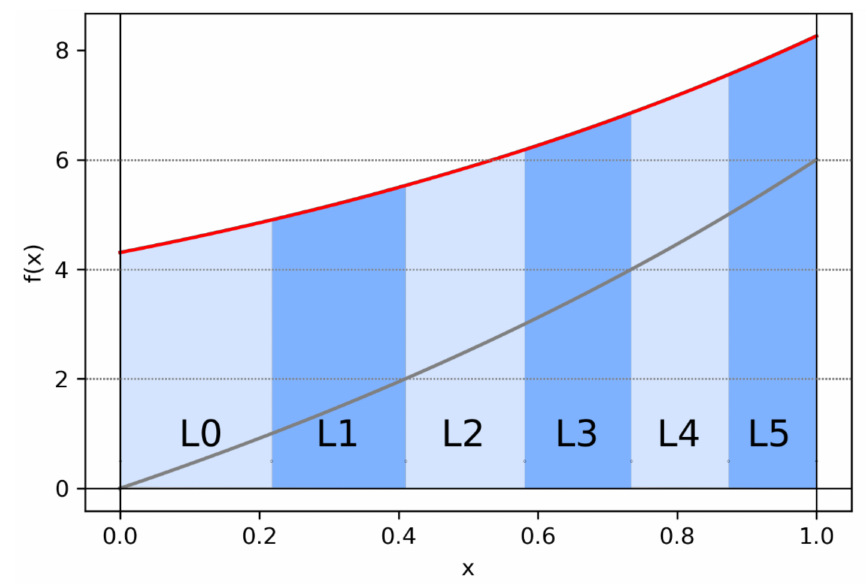
Figure 1. Interval distribution for readiness levels. The red curve represents the function f(x). After integrating this function, we get the value of the size of the area under the curve f(x), which is represented in the graph by the green curve. Levels are determined by the size of the area under the red curve in the interval <0; 1>, which is represented by the green curve. Each level is given by an area of size 1. The achieved level is therefore the largest integer multiple of area of size 1, which can be realised on the interval <0,x>. Table 7 shows the calculated range for the interval <0; 1> for each of the six preparedness